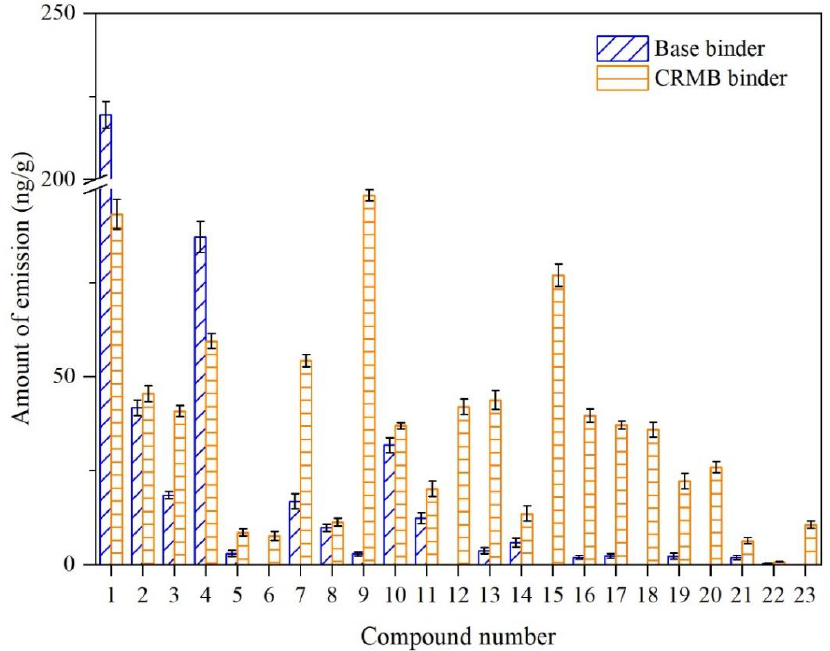
Figure 6. Emission comparison of each VOC fingerprint compound between the base and CRMB binders.